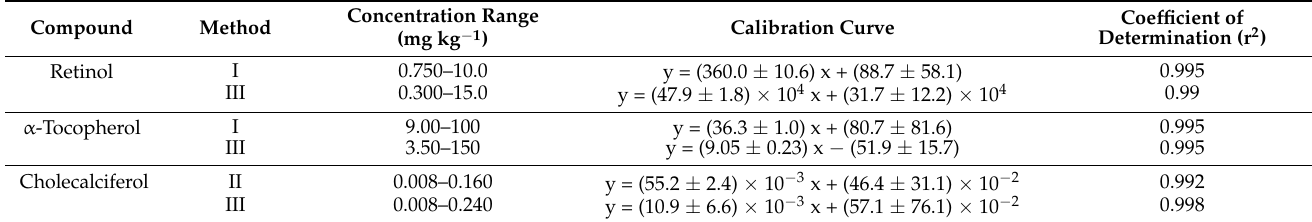
Table 3. Standard addition calibration curves and correlation factors for each analyte.